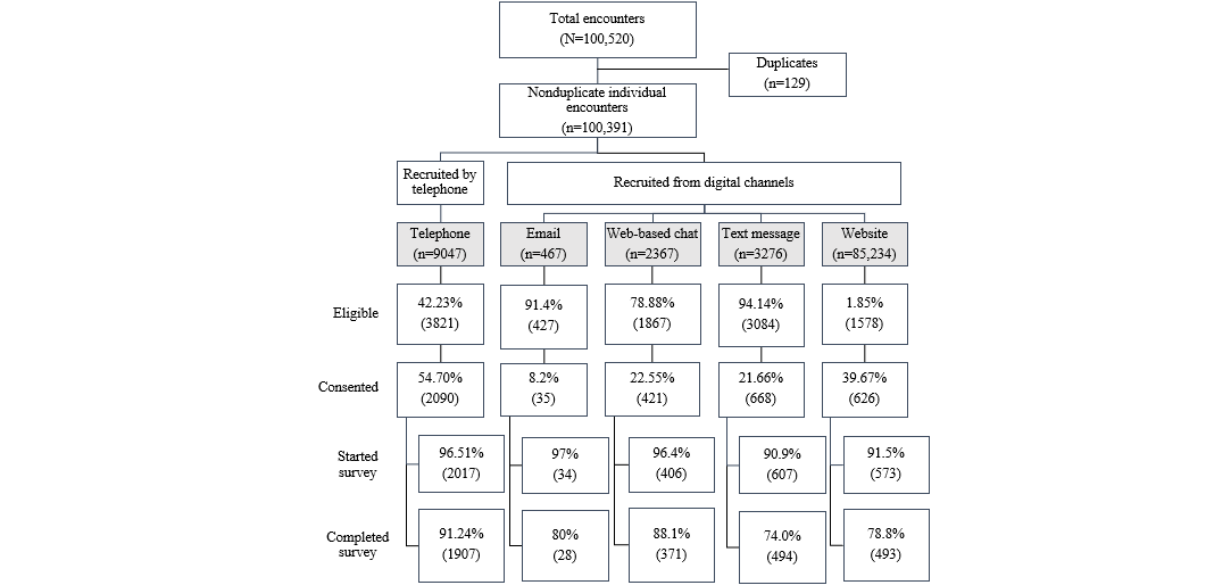
Figure 2. Cancer Communication Channels in Context Study accrual by recruitment channel, January-November